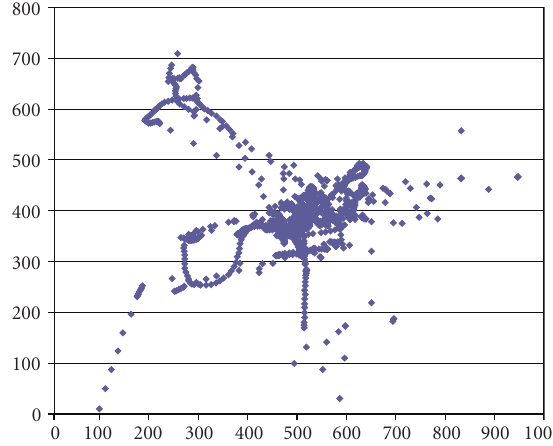
Figure 9: Eye-gaze path for 1 subject, expt 3, horizontal rows configuration.